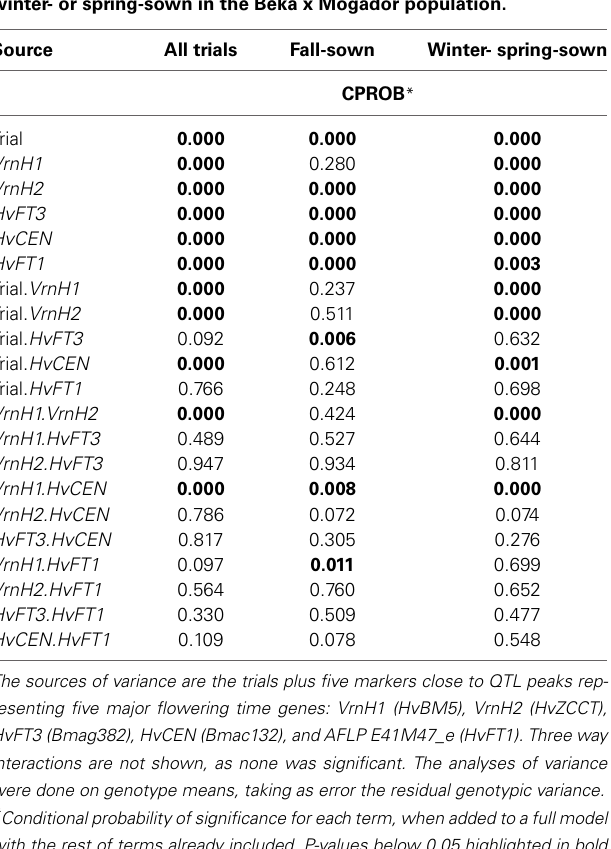
Table 4 | Probabilities of significance from three analyses of variance of flowering date recorded at six field trials, three fall-sown and three winter- or spring-sown in the Beka x Mogador population.